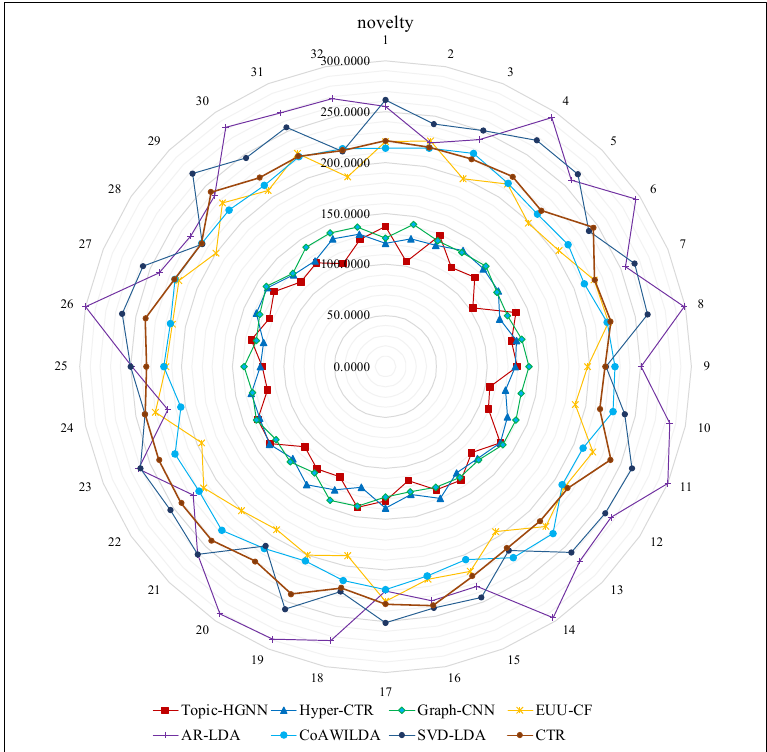
Figure 6. Comparison of recommendation result novelty.